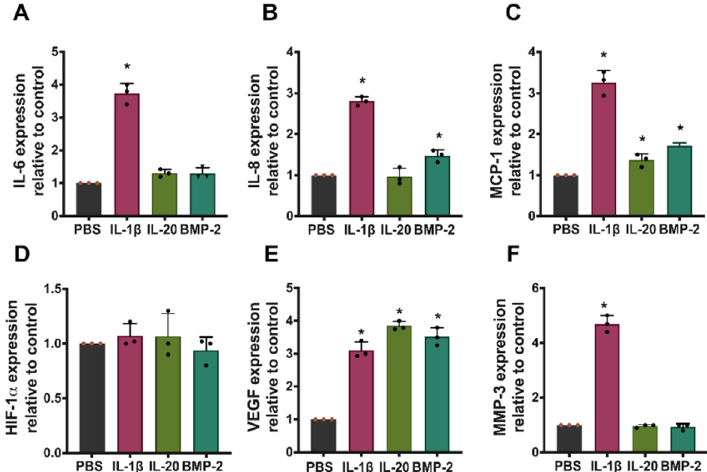
Figure 2. Effects of IL-1 β , IL-20, and BMP-2 in IVD cells under hypoxia. IVD cells were exposed to phosphate-buffered saline (PBS), IL-1 β (10 ng/mL), IL-20 (200 ng/mL), and BMP-2 (200 ng/mL) under hypoxia for six hours. (A–F) The expression levels of indicated genes were analyzed using RT-qPCR with specific primers. β -actin was an internal control. Dots on the bar chart indicated the triplicates for each group. * p < 0.05 compared with PBS-treated controls. Data are expressed as mean ± SD and are representative of three independent experiments.